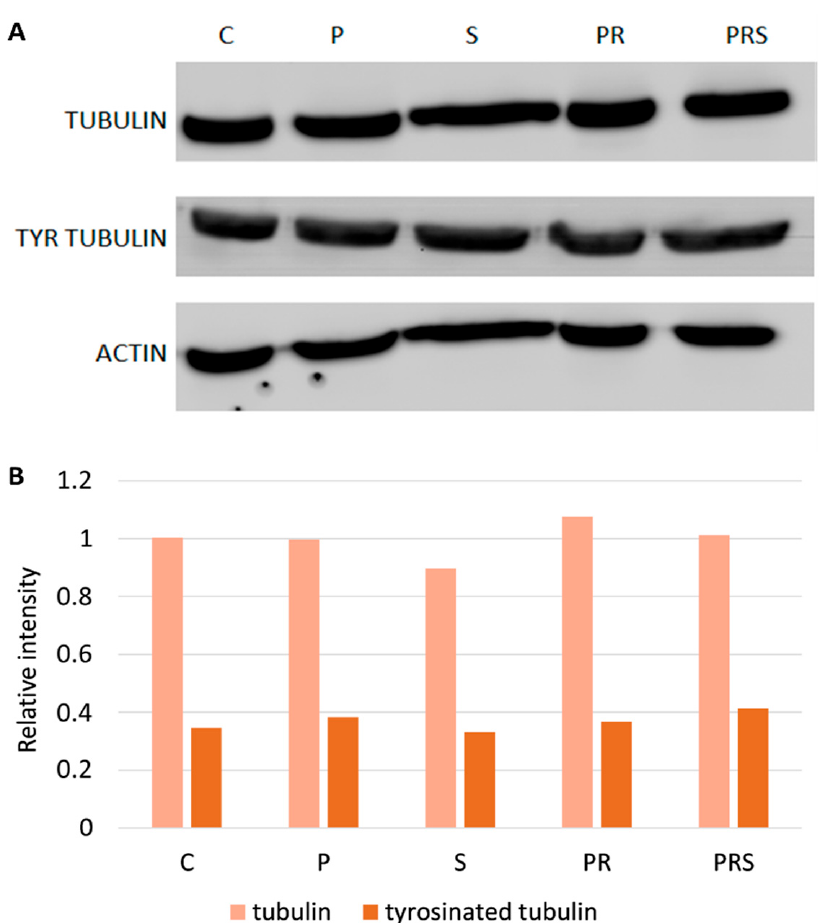
Figure 8. Detection of tubulins in pollen samples: ( A ) immunoblots with antibodies to tubulin, tyrosinated and acetylated tubulin as well to actin. Lane 1, control sample (C); Lane 2, primed sample (P); Lane 3, stressed sample (S); Lane 4, primed and recovered sample (PR); Lane 5, primed, recovered and stressed sample (PRS). A total of 30 µ g of proteins was loaded in each lane; ( B ) relative quantitation of tubulin (TUB) and tyrosinated tubulin (TYR TUB). All samples were normalized using the actin signal.